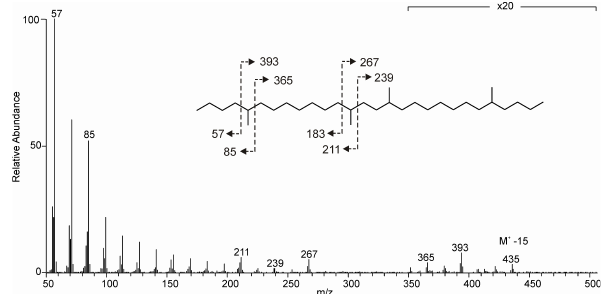
Fig. 3. Mass spectrum (electron spray ionisation) of compound “z” from Stordalen mire (Fig. 2d) with the structure tentatively identi- fied as 5,13,16,24-tetramethyloctacosane. The mass spectrum has been corrected for background. Note that the vertical scale is mag- nified by a factor 20 from m/z 350